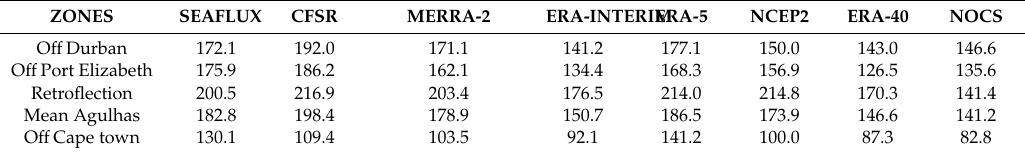
Table 2. Annual mean latent heat flux (W / m 2 ) at four locations: o ff Durban, o ff Port Elizabeth, and Retroflection region and the average of the three Agulhas points, and o ff Cape Town for seven considered data sets. The products are averaged using the data resampled on the grid of SEAFLUX (0.25 ◦ × 0.25 ◦ ). ZONES SEAFLUX CFSR MERRA-2 ERA-INTERIMERA-5 NCEP2 ERA-40 NOCS O ff Durban